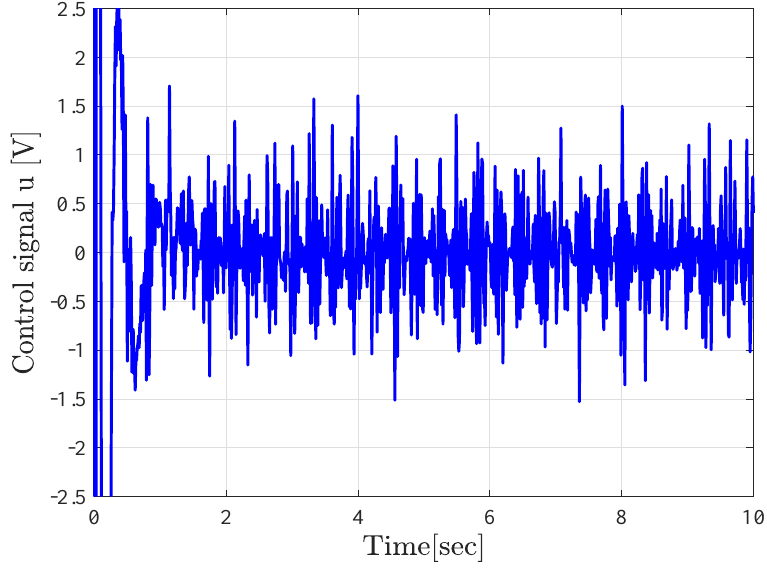
Figure 3. Evolution of the control signal u